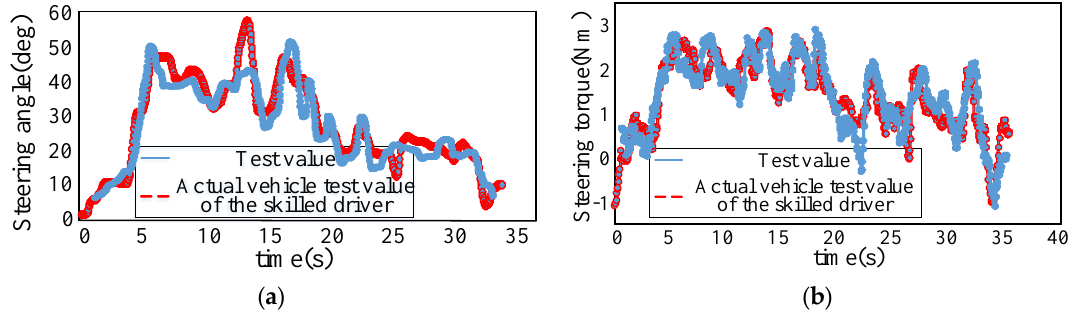
Figure 13. Comparison of test results under normal right-steering condition. ( a ) Comparison of steering wheel angle; ( b ) Comparison of steering wheel torque.